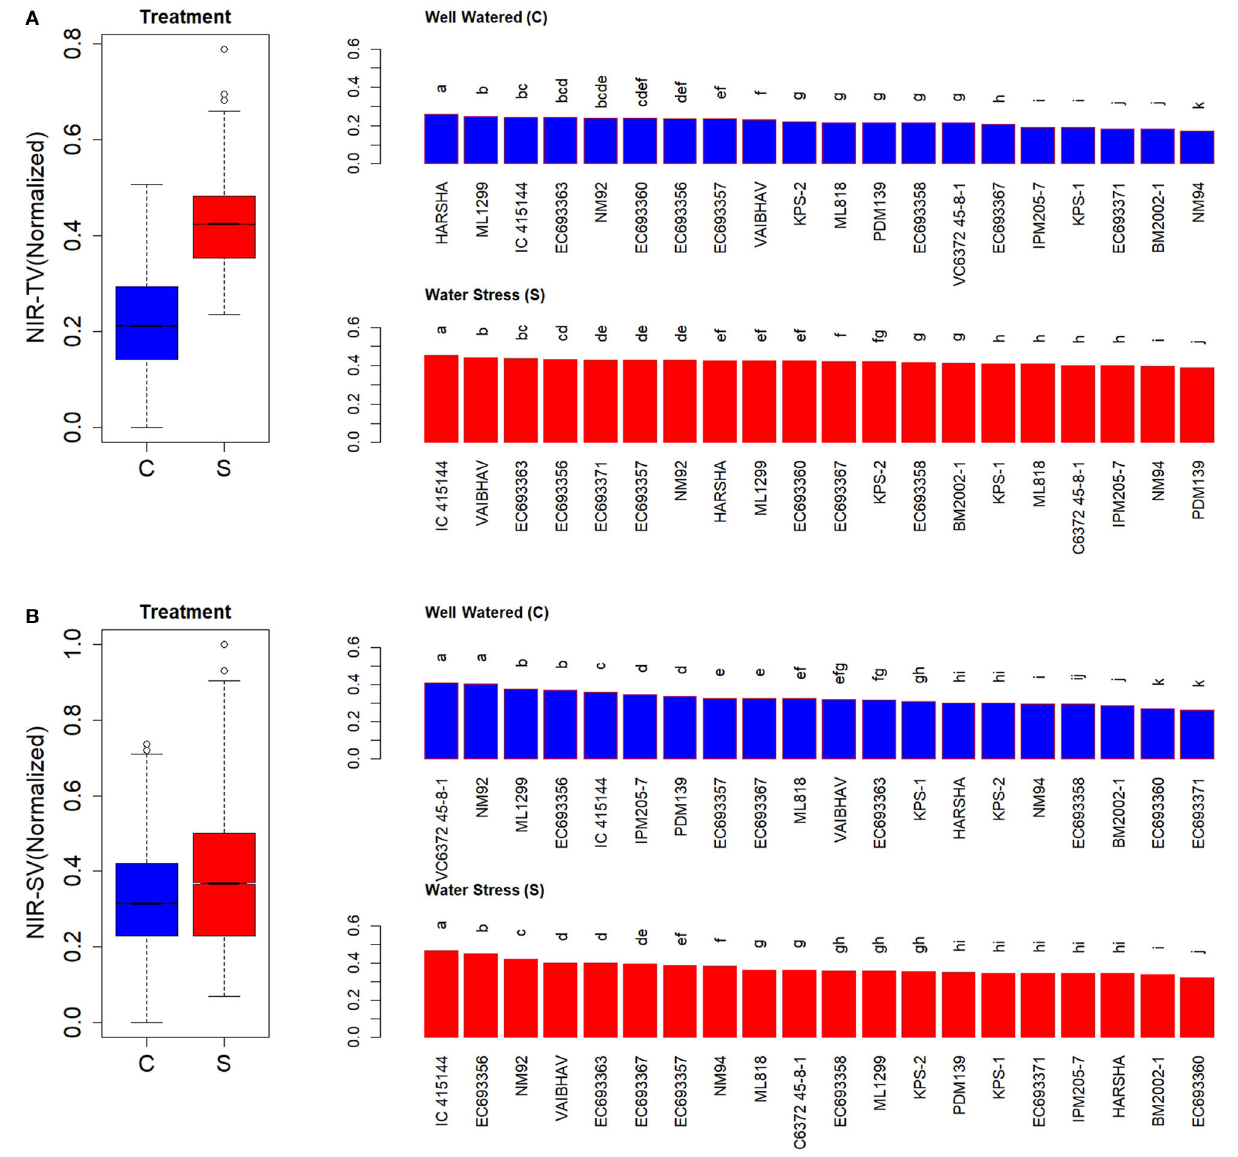
FIGURE 9 | Genetic variation in the tissue water content of mung bean genotypes as indicated by near-IR (NIR) signals. (A) Values indicate normalized values of NIR signals received from the top view and (B) side view of well-watered (c) and water-stressed (s) plants of mungbean. Values for each box in the treatment effect represent 60 observations (3 replications and 20 genotypes) and each bar in the genotype effect for each treatment represents mean values of three replications. Letters represent the significance of differences among mean values as computed by the Duncan multiple range test at 0.95 CI. Genotypes with common letters are not significantly